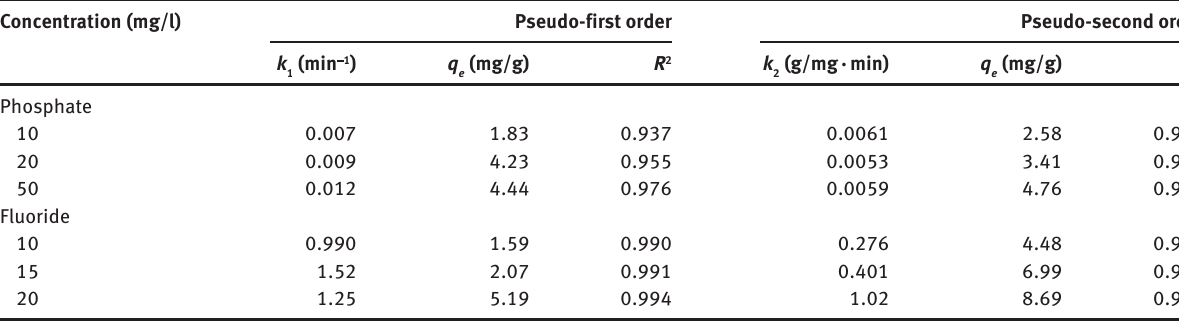
Table 1: Parameters for pseudo-first- and pseudo-second-order models for removing phosphate and fluoride. Concentration (mg/l)